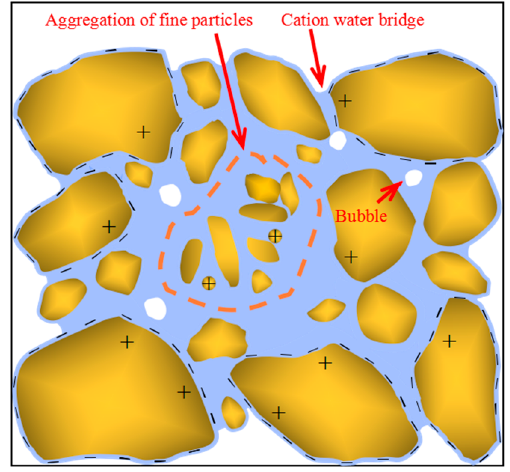
Figure 8. Aggregation state of suppressed soil.